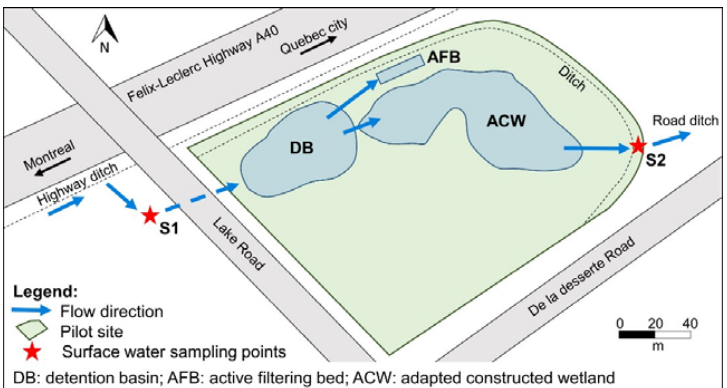
Figure 2. Surface water sampling points in the pilot site located in Saint ‐ Augustin Lake watershed (Quebec). Red stars represent surface sampling points: S1 (influent water) and S2 (effluent water).